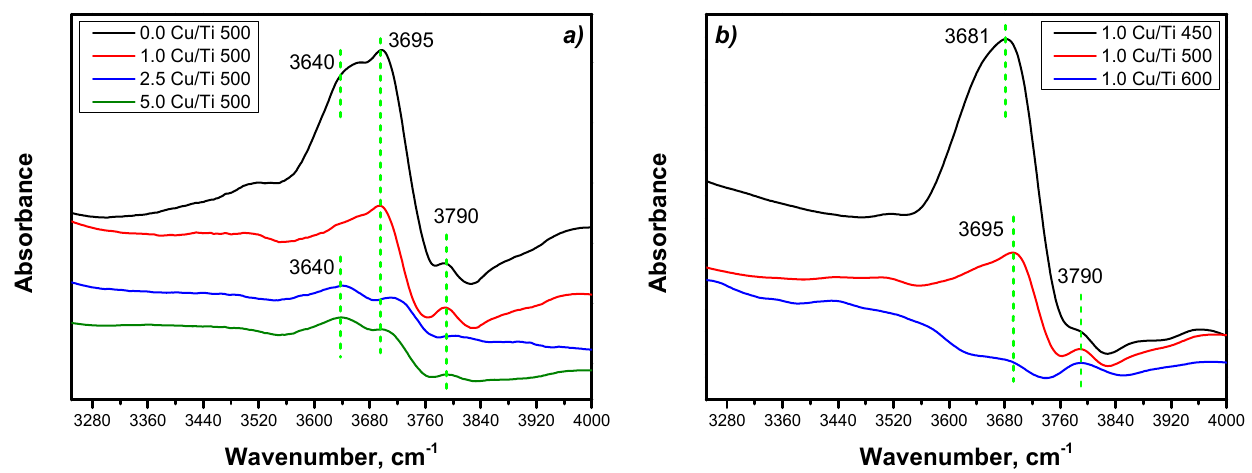
Figure 6. FTIR spectra for ( a ) X Cu/Ti, and ( b ) 1.0 Cu/Ti Y in the absorption band of hydroxyl species in the 3200–4000 cm − 1 region from 25 up to 400 °C.